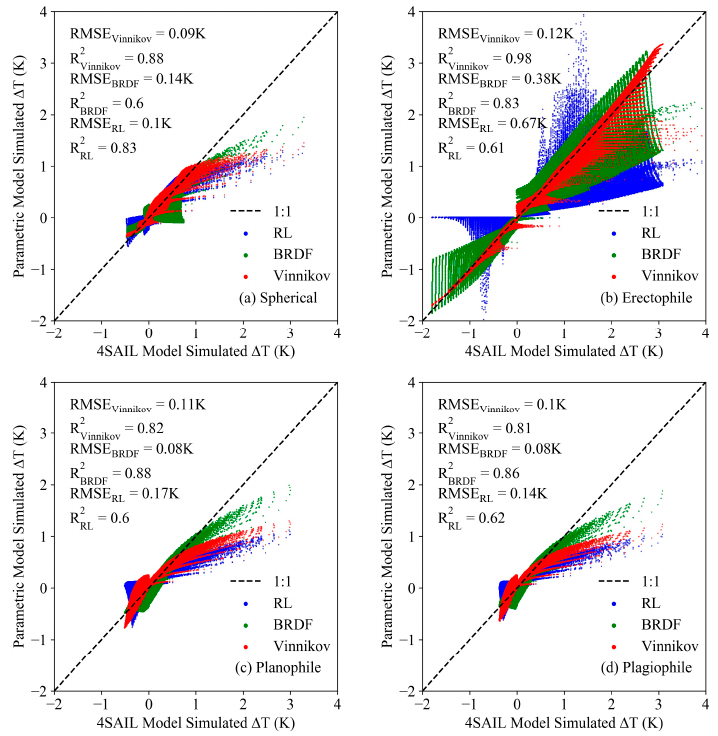
Figure 4. Comparison of anisotropy obtained with parametric models against 4SAIL for ( a ) spherical; ( b ) erectophile; ( c ) planophile; and ( d ) plagiophile. Remote Sens. 2018 , 10 , x FOR PEER REVIEW